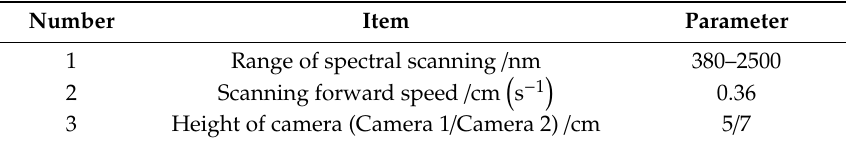
Table 1. Parameters of GaiaSorter hyperspectral sorting system.